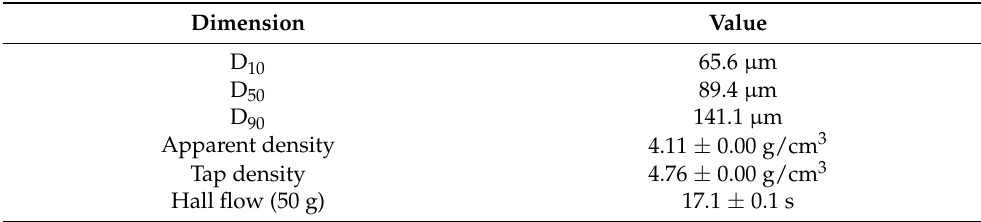
Table 2. Properties of the X37CrMoV5-1